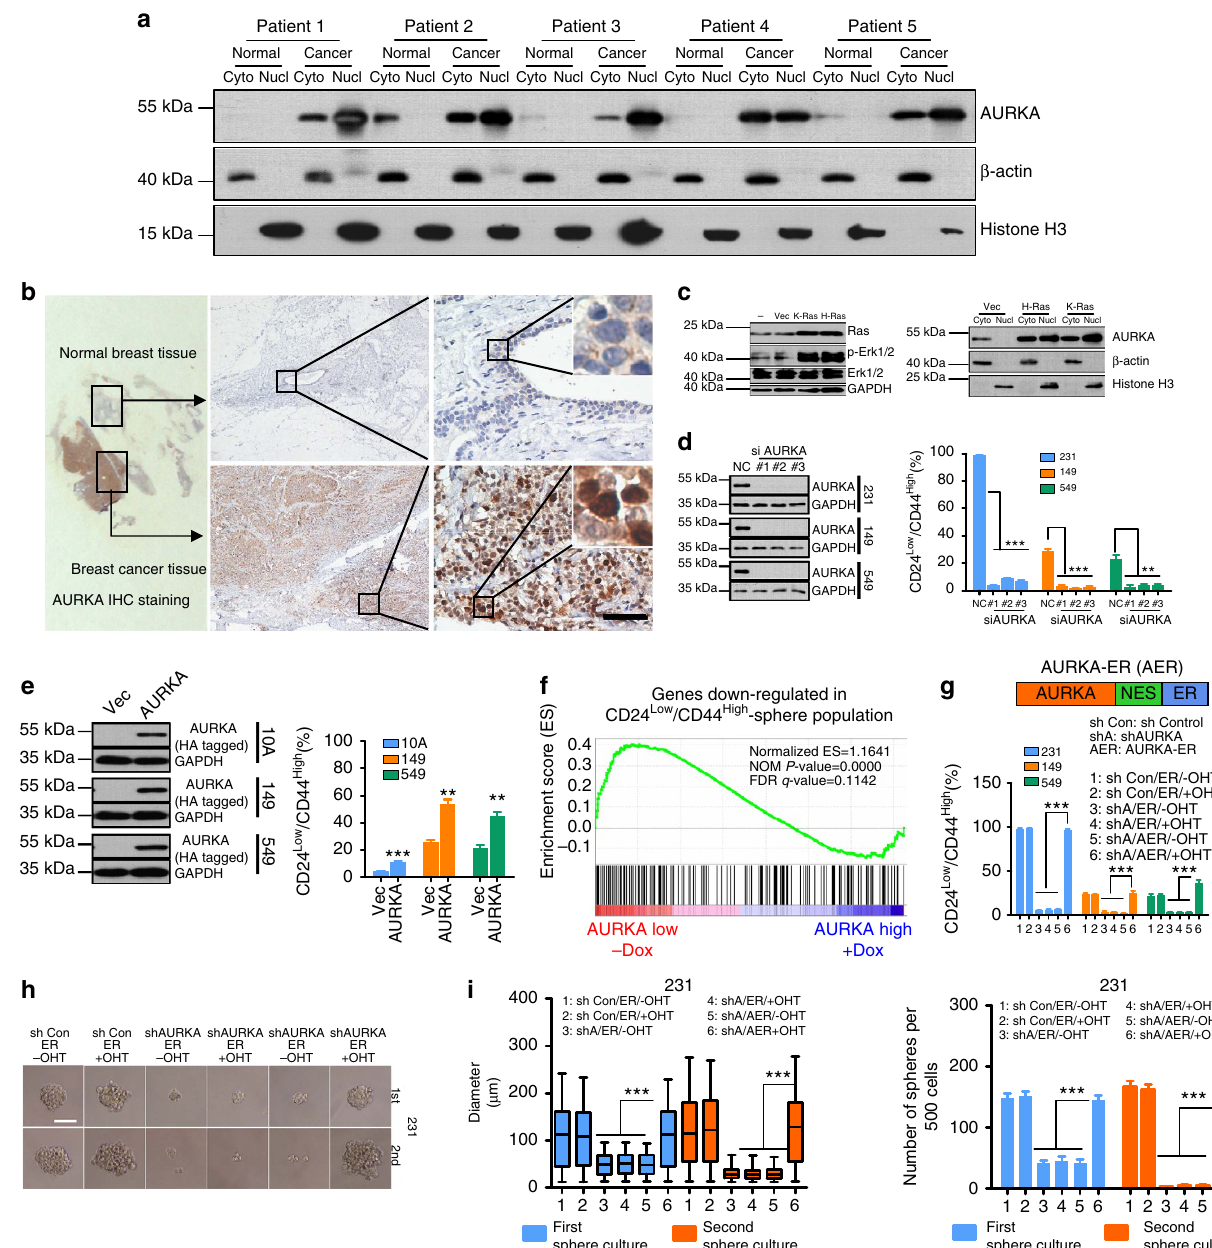
Figure 1 | Nuclear AURKA enhances breast cancer stem cell phenotype. ( a ) Primary cells were extracted from breast cancer tissues and adjacent normal breast tissues. The cytoplasmic and nuclear protein lysates representing an equal number of cells were subjected to immunoblot (IB) analysis. ( b ) Representative IHC staining showing AURKA expression. Images were magnified with a (cid:2) 4 or (cid:2) 40 objective. Scale bar, 50 m m. ( c ) Mouse embryonic fibroblasts (MEFs) overexpressing K-Ras, H-Ras and the vector control (Vec) were analysed by IB for indicated antibodies (left panel). Cytoplasmic and nuclear lysates of WT ( (cid:3) )-, vector control (Vec)-, K-Ras- and H-Ras-overexpressed MEFs were subjected to IB analysis (right panel). ( d ) MDA-MB-231, SUM149 or BT549 cells were treated with AURKA siRNAs for 96h. Adherent cells were collected for IB analysis (left panel), CD24/CD44 staining and CD24 low /CD44 high population analysis via flow cytometry (right panel). ( e ) HA-tagged AURKA was overexpressed in MCF-10A, SUM149 and BT549 cells through lentivirus-mediated gene transfer. Puromycin (1 m gml (cid:3) 1 ) selected cells were collected for IB analysis (left panel), CD24/CD44 staining and CD24 low /CD44 high population analysis by using flow cytometry (right panel). ( f ) Gene expression data acquired from a public database (GEO ID: GSE23541, the group of AURKA þ Dox and AURKA-Dox) were subjected to GSEA using the gene expression signature that was downregulated in the CD24 low /CD44 high -sphere population. ( g ) MDA-MB-231 cells were co-transfected with shRNA vector (sh Control or shAURKA) and the overexpression vector (ER or AER) via lentivirus-mediated gene transfer. Puromycin (1 m gml (cid:3) 1 ) and blasticidin (2 m gml (cid:3) 1 ) double selected cells were subjected to CD24/CD44 staining and analysis via flow cytometry. ( h ) Cells derived from g were subjected to mammosphere culture assay (6 days, upper panel) and the secondary passaging (additional 6 days, lower panel). Scale bar, 100 m m. ( i ) Data from three independent experiments derived from g were used for quantitative analysis of mammosphere size (diameter, F ) and mammosphere number. Left panel shows distribution pattern of mammosphere size from MDA-MB-231 (Kruskal–Wallis test followed by Dunn’s multiple comparison test, *** P o 0.001). Right panel shows the number of mammospheres ( F4 60 m m). Bars represent the means ± s.e.m. of three independent experiments (analysis of variance (ANOVA) followed by least significant difference (LSD) test; * P o 0.05, ** P o 0.01, *** P o 0.001). NATURE COMMUNICATIONS|7:10180|DOI: